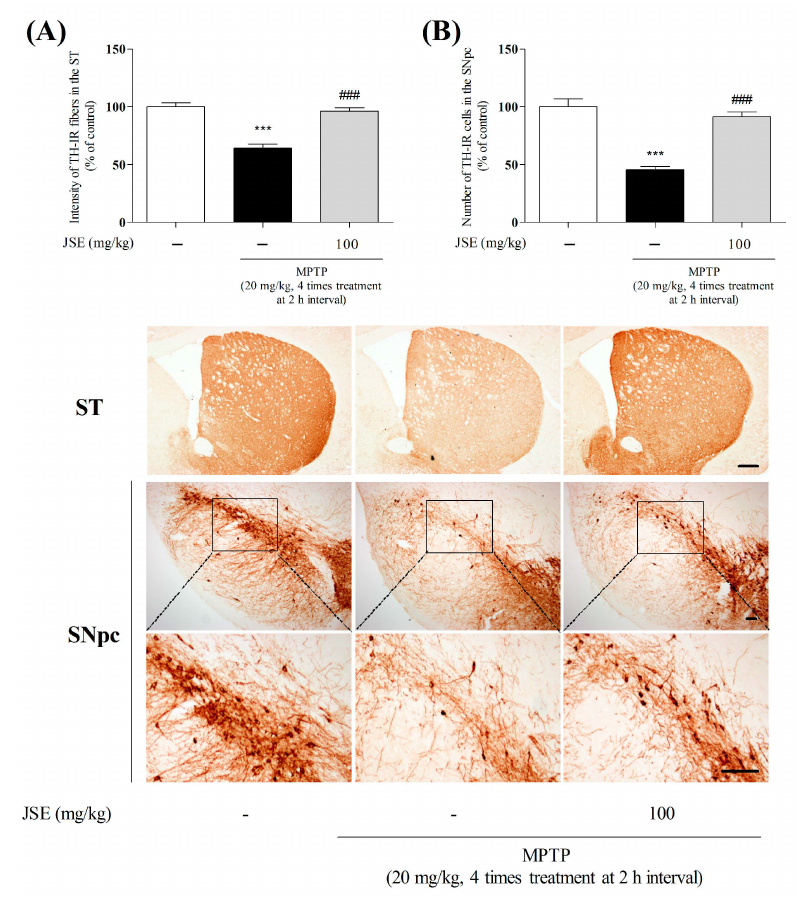
Figure 5. Effects of JSE against 1-methyl-4-phenyl-1,2,3,6-tetrahydropyridine (MPTP)-induced neurotoxicity in vivo . Dopaminergic fibers and neurons were visualized by anti-tyrosine hydroxylase (TH) immunostaining. The optical density in the striatum (ST) ( A ) was measured and the number of TH-positive neurons in the substantia nigra pars compacta (SNpc) ( B ) was counted. Representative photomicrographs are shown. The squares are concentration areas of TH-positive neurons in the SNpc. Scale bar = 100 µ m. Values were expressed as means ˘ SEM. *** p < 0.001 vs. the control group; ### p < 0.001 vs. the MPTP-only treated group.